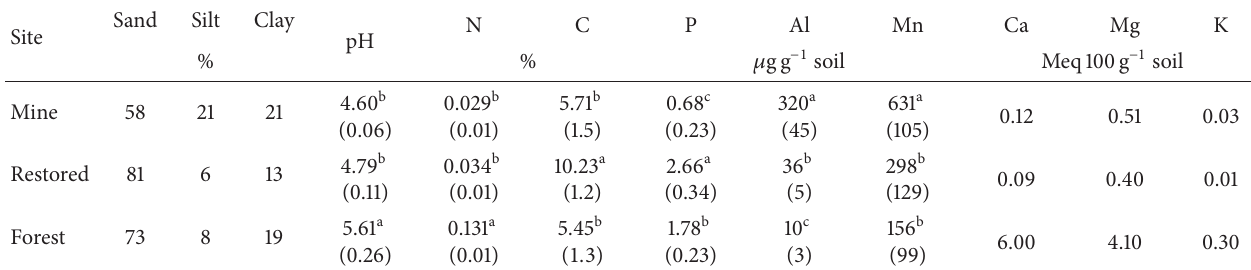
Table 1: The percentage of soil separates and levels of pH, nutrients, and Al in soil and mining spoil from each of the Pisolithus sporocarp collection sites. Values represent the mean with standard error in parentheses. For each column, means with the same letter do not differ significantly at p <